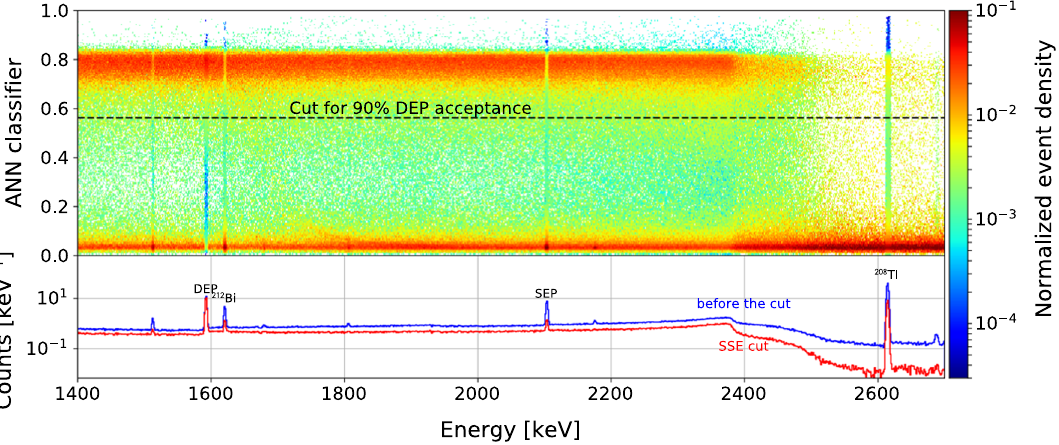
Fig. 16 Comparison of the measured and simulated energy spectra acquired with 228 Th (top panel) and 56 Co (bottom panel) sources. A good agreement is achieved in the 700 keV–3000 keV range, which is the region of interest of the investigated PSA method. The measured